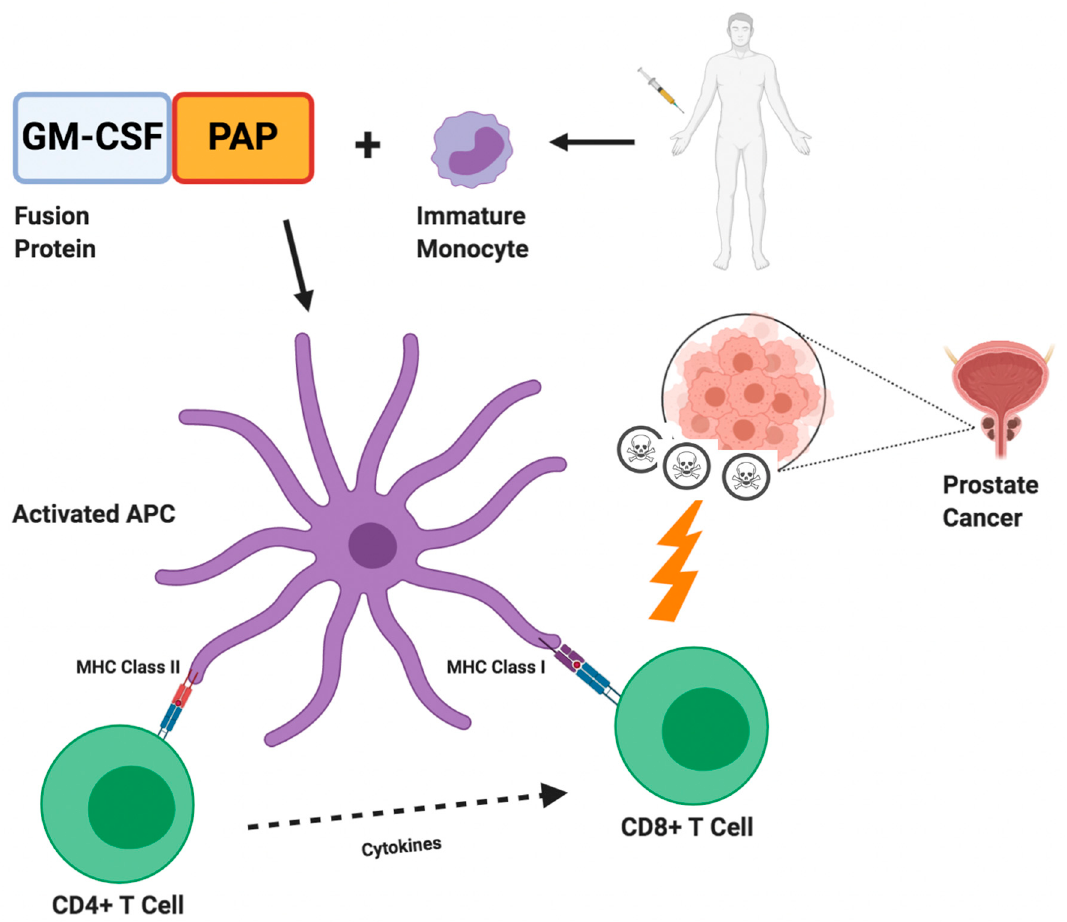
Figure 1. Sipuleucel-T in prostate cancer. Firstly, the cancer vaccine sipuleucel-T requires leukapheresis of immature immune cells; leukapheresis is then followed by incubation with specific fusion protein (PA2024), consisting of prostatic acid phosphatase (PAP) coupled with granulocyte-macrophage colony stimulating factor (GM-CSF). Subsequently, cells are re-infused allowing for APC maturation and activation of CD4 + and CD8 + T cells, which in turn are able to recognize and kill PAP presenting tumor cells.